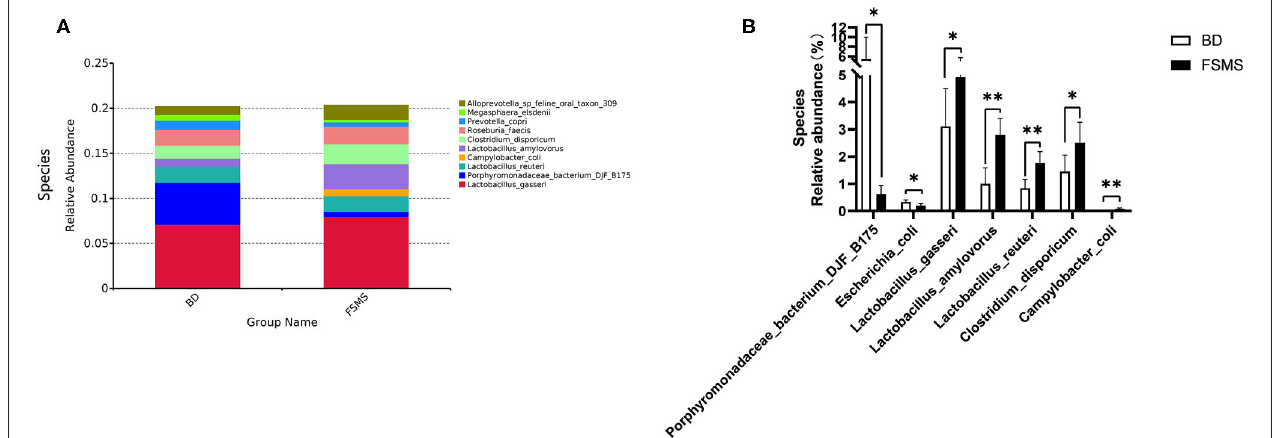
FIGURE 7 | Relative abundance of bacterial species in the colonic digesta of pigs (A) . Significant changed species in the colonic digesta (B) . Values were expressed as means ± SEM ( n = 6). Statistical differences were calculated by Duncan: * p < 0.05, ** p <